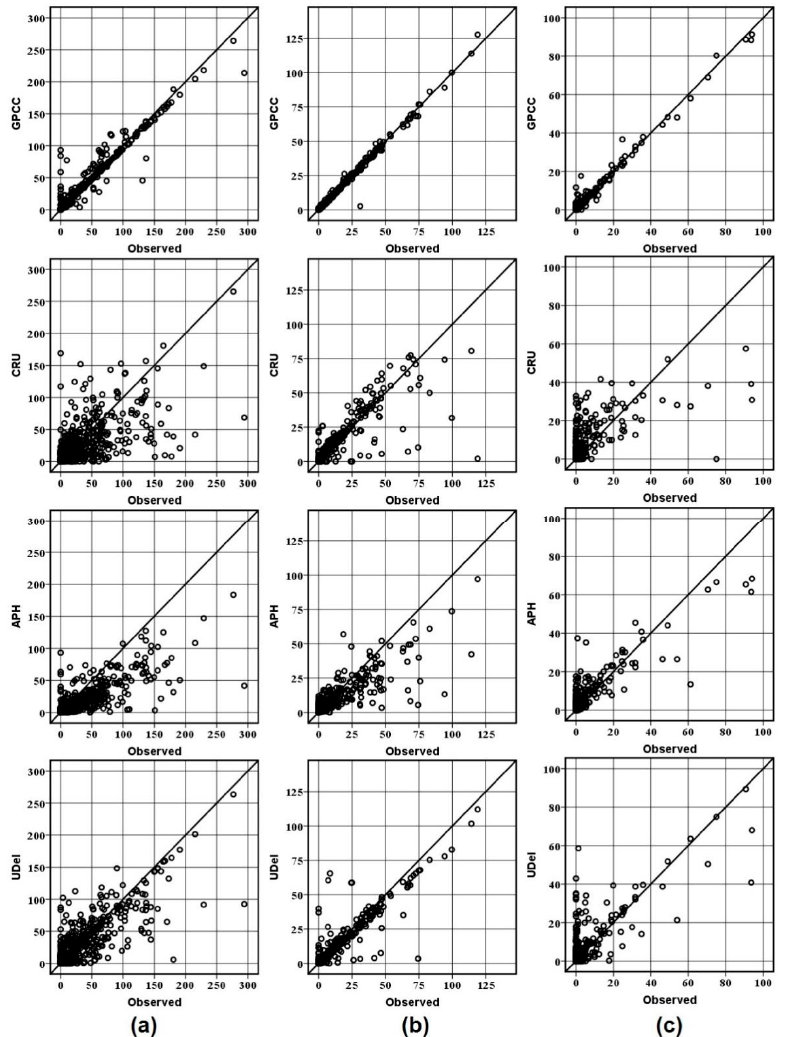
Figure 7. Scatter plot of observed and gauge-based gridded precipitation at ( a ) semi-arid, ( b ) arid, and ( c ) hyper-arid stations.